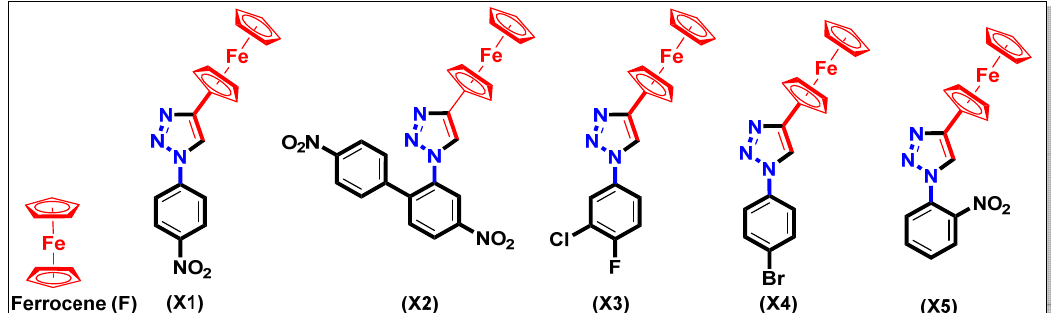
Table 1. Experimental details and crystal structure data for compounds X1 and X5 .